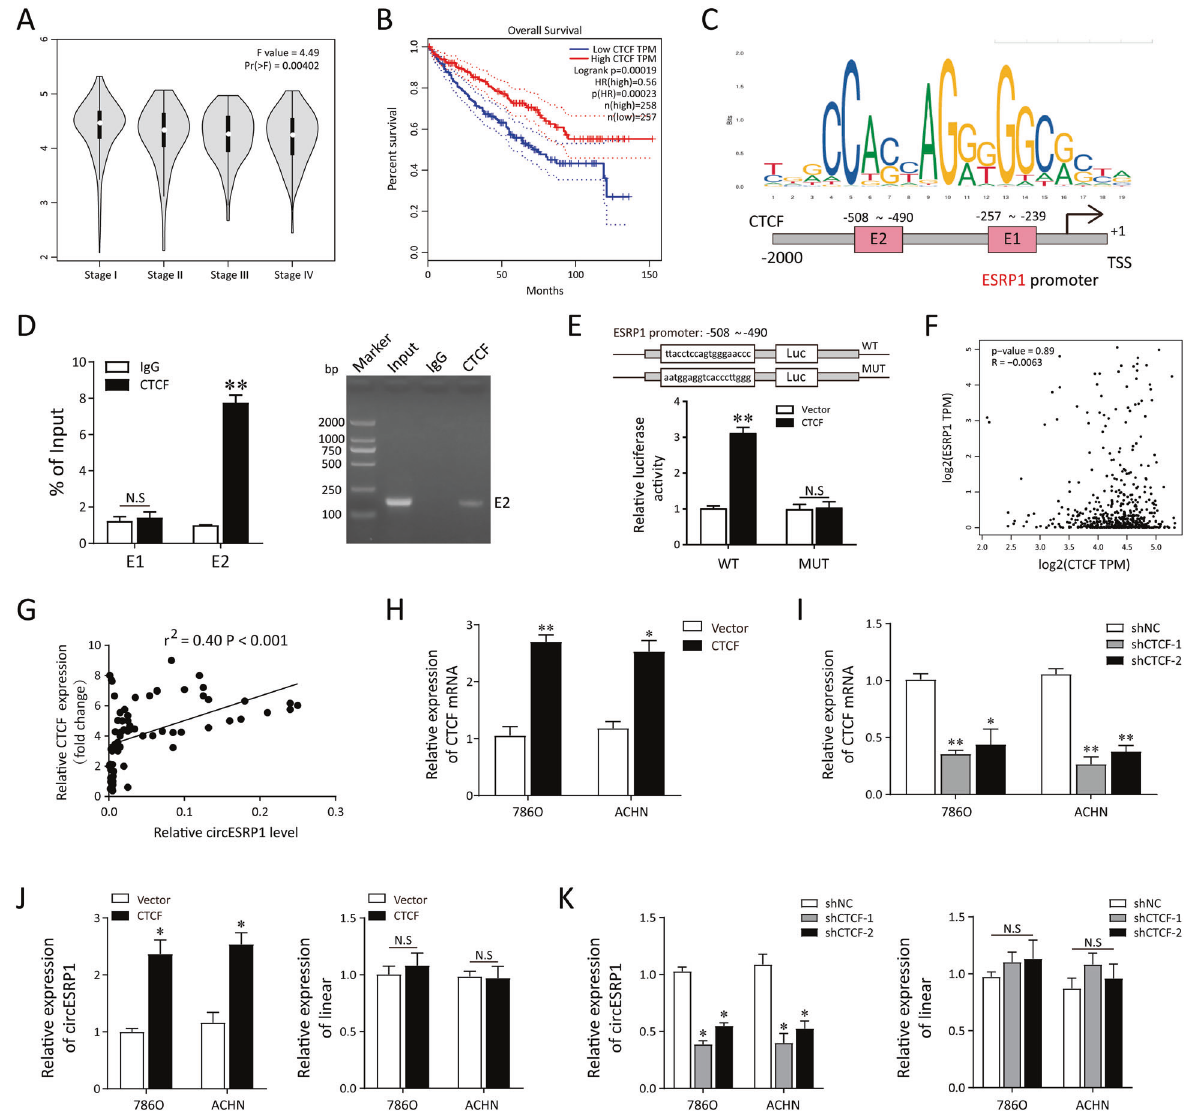
Fig. 3 CTCF accelerates the biogenesis of circESRP1 rather than the linear mRNA of ESRP1. A Correlation between CTCF Expression and Tumor Stage in clear cell renal cell carcinoma Patients (GEPIA, http://gepia.cancer-pku.cn/). B The Prognostic Value of mRNA Level of CTCF in clear cell renal cell carcinoma Patients (GEPIA). C JASPAR (http://jaspar.genereg.net/) indicated that CTCF shared with the binding sites with the promoter region of ESRP1. D CHIP-PCR was performed with CTCF antibody in 786O cells to detect the enrichment of potential binding sequences of ESRP1 promoter region. The qRT-PCR product was validated by agarose gel electrophoresis. E Luciferase reporter assay showed that CTCF bound to E2 wild type rather than mutant type. F No signi fi cant correlation between ESRP1 level and CTCF level in clear cell renal cell carcinoma Patients based on the TCGA (GEPIA). G Correlation between CTCF expression and circESRP1 level in our RCC clinical samples ( n = 79). H Stable overexpression plasmid for CTCF was transfected into ccRCC cells (786O, ACHN) to increase CTCF expression. The CTCF mRNA level was detected by qRT-PCR. I Stable silencing shRNA were transfected into ccRCC cells (786O, ACHN) to silence CTCF expression. The level of CTCF in 786O and ACHN cells was determined by qRT-PCR. J , K RT-PCR was performed to detect the expression of circESRP1 and linear ESRP1 in 786O and ACHN cells transfected with oe-CTCF, shCTCF, and control. Data are the means ± SEM of three independent experiments. * p < 0.05; ** p < 0.01; N.S, not signi fi